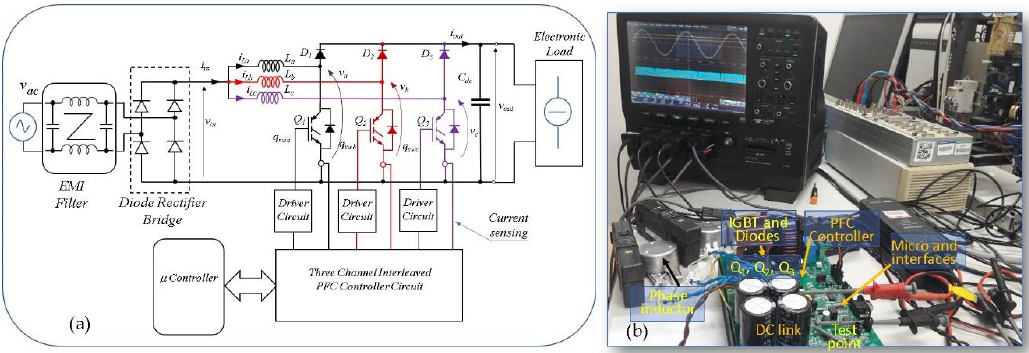
Figure 10. ( a ) Interleaved three cells boost interleaved PFC converter set-up with controller circuit. The PFC circuit is linked to a full-bridge diode rectifier, an electronic load to emulate a current constant load is connected to the converter output. ( b ) Photo of measurement setup. Table 2. Main PFC electrical parameters of the experimental prototype.